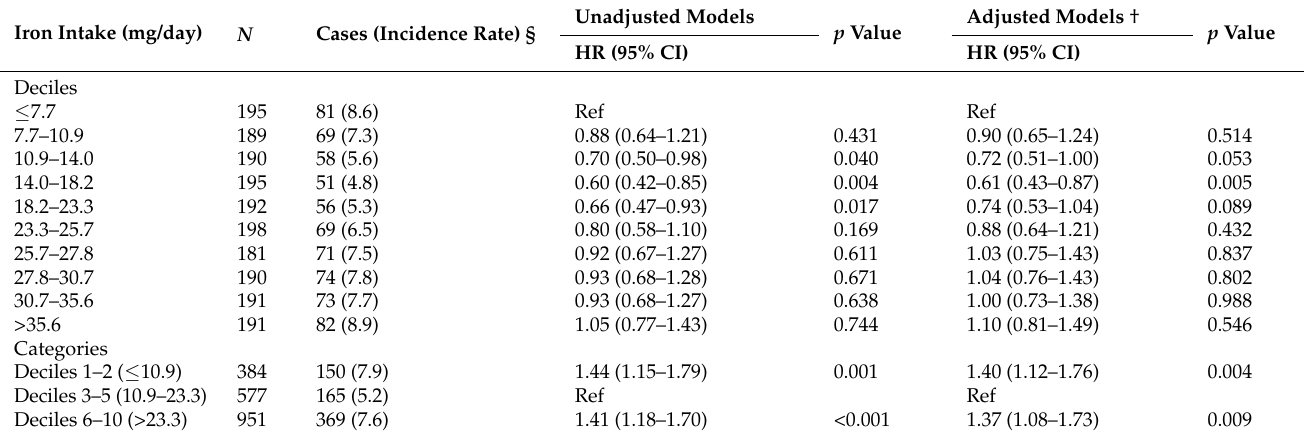
Table 4. The association between dietary iron intake and the risk of JSN-score